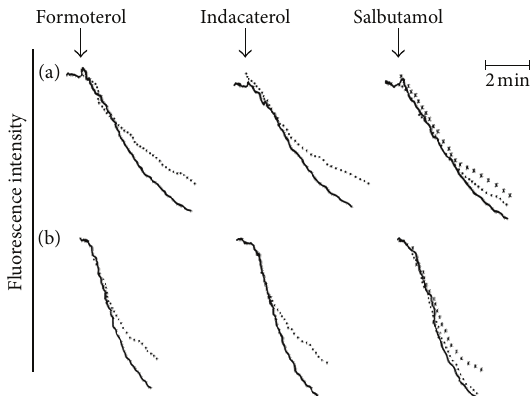
Figure 7: Mn 2+ -quenching of fura-2 fluorescence traces from 2 representative experiments ( 𝑛 = 3 in the series) showing the effects of formoterol, indacaterol (100nM), and salbutamol (100 and 1000 nM) on the alterations in cytosolic Ca 2+ concentrations follow- ing activation of the cells with either 1 𝜇 M fMLP (a) or 200 nM PAF (b). The 3 lines in each trace correspond to the control system (—) and systems treated with 100 nM of each drug ( eeeee ) or 1000nM salbutamol (xxxx); ↓ denotes the addition of either fMLP or